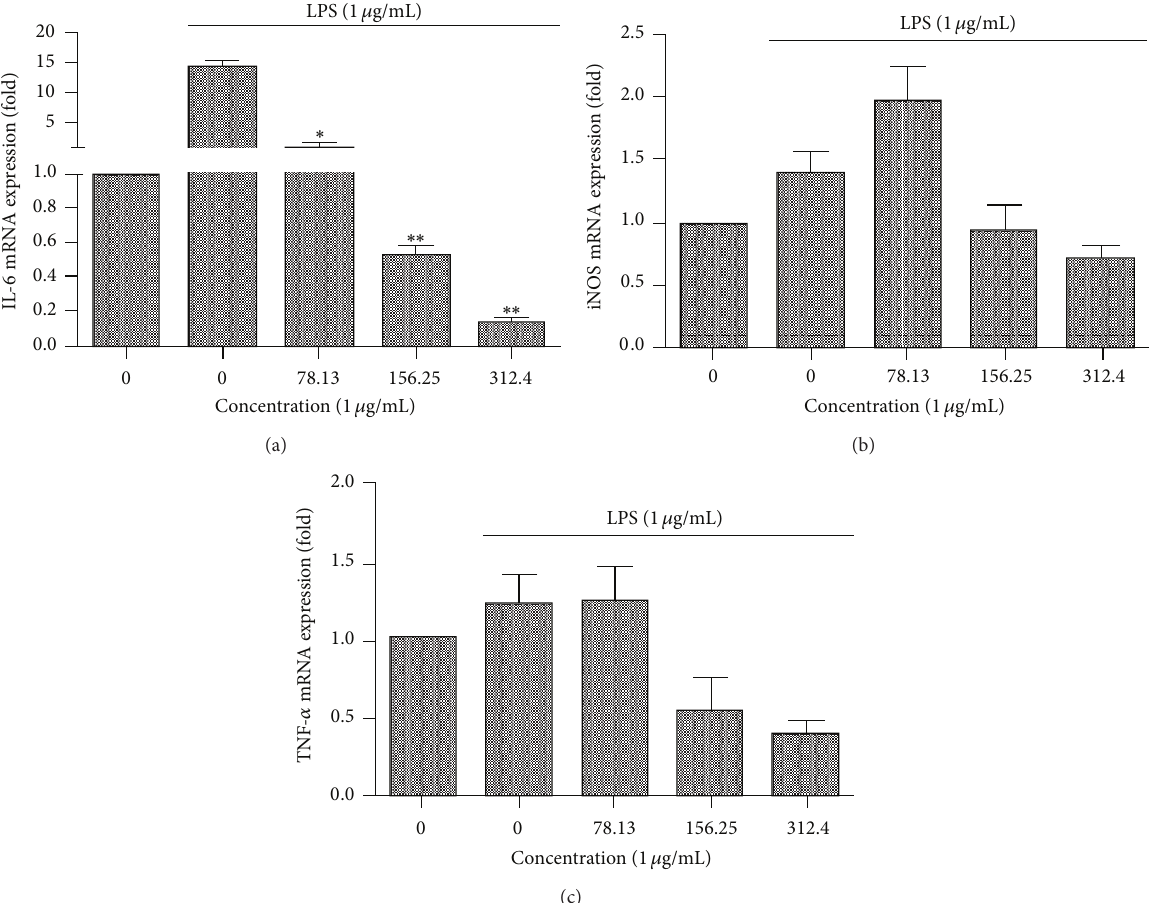
Figure 5: Anti-inflammatory activity of Ximenia caffra leaf extract measured by RT-qPCR in RAW 264.7 macrophage cells (a) IL-6 mRNA expressions after treatment; (b) iNOS mRNA expression after treatment; (c) TNF- 𝛼 mRNA expression after treatment.